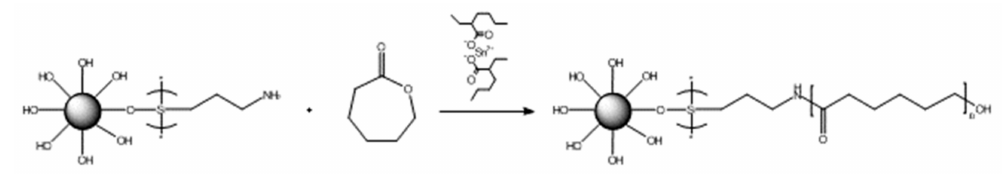
Figure 1. A scheme of the PCL grafting reaction.